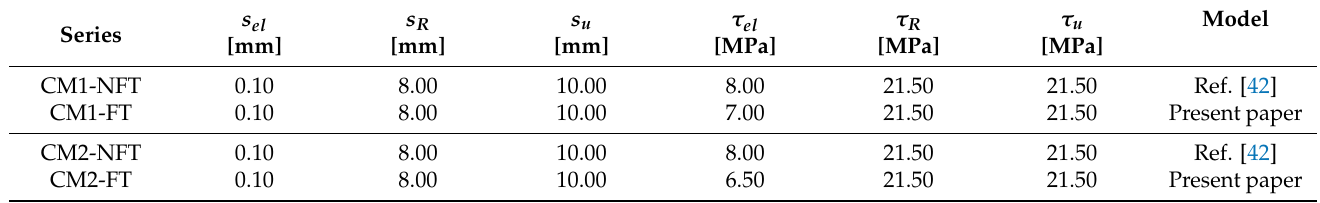
Table 4. Calibration of the six parameters in the local bond-slip law for unconditioned CM1 and CM2 specimens (labelled, respectively, CM1-NFT and CM2-NFT) as well as for conditioned CM1 and CM2 specimens (labelled, respectively, CM1-FT and CM2-FT) used in the previous model of Ref. [42] and in the last one, respectively.